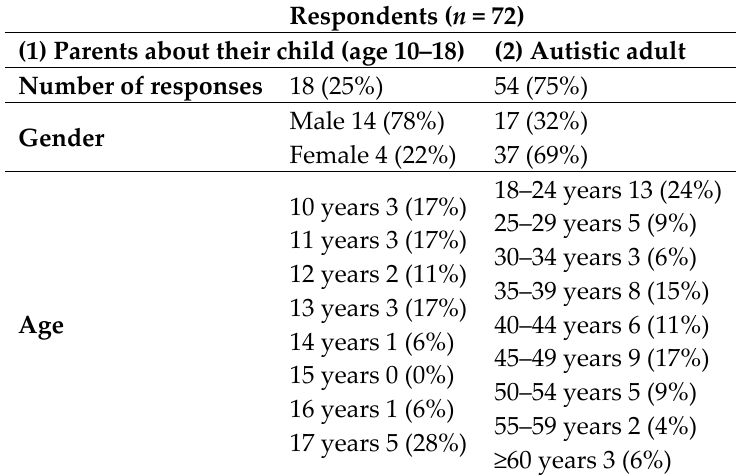
Table 1. Demographics of the participants of the online survey.